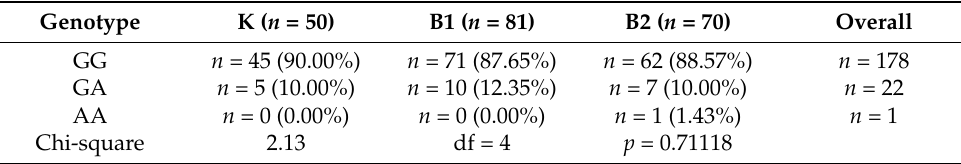
Table 2. Frequencies of various genotypes of the rs17300539 adiponectin gene polymorphism in the study groups.